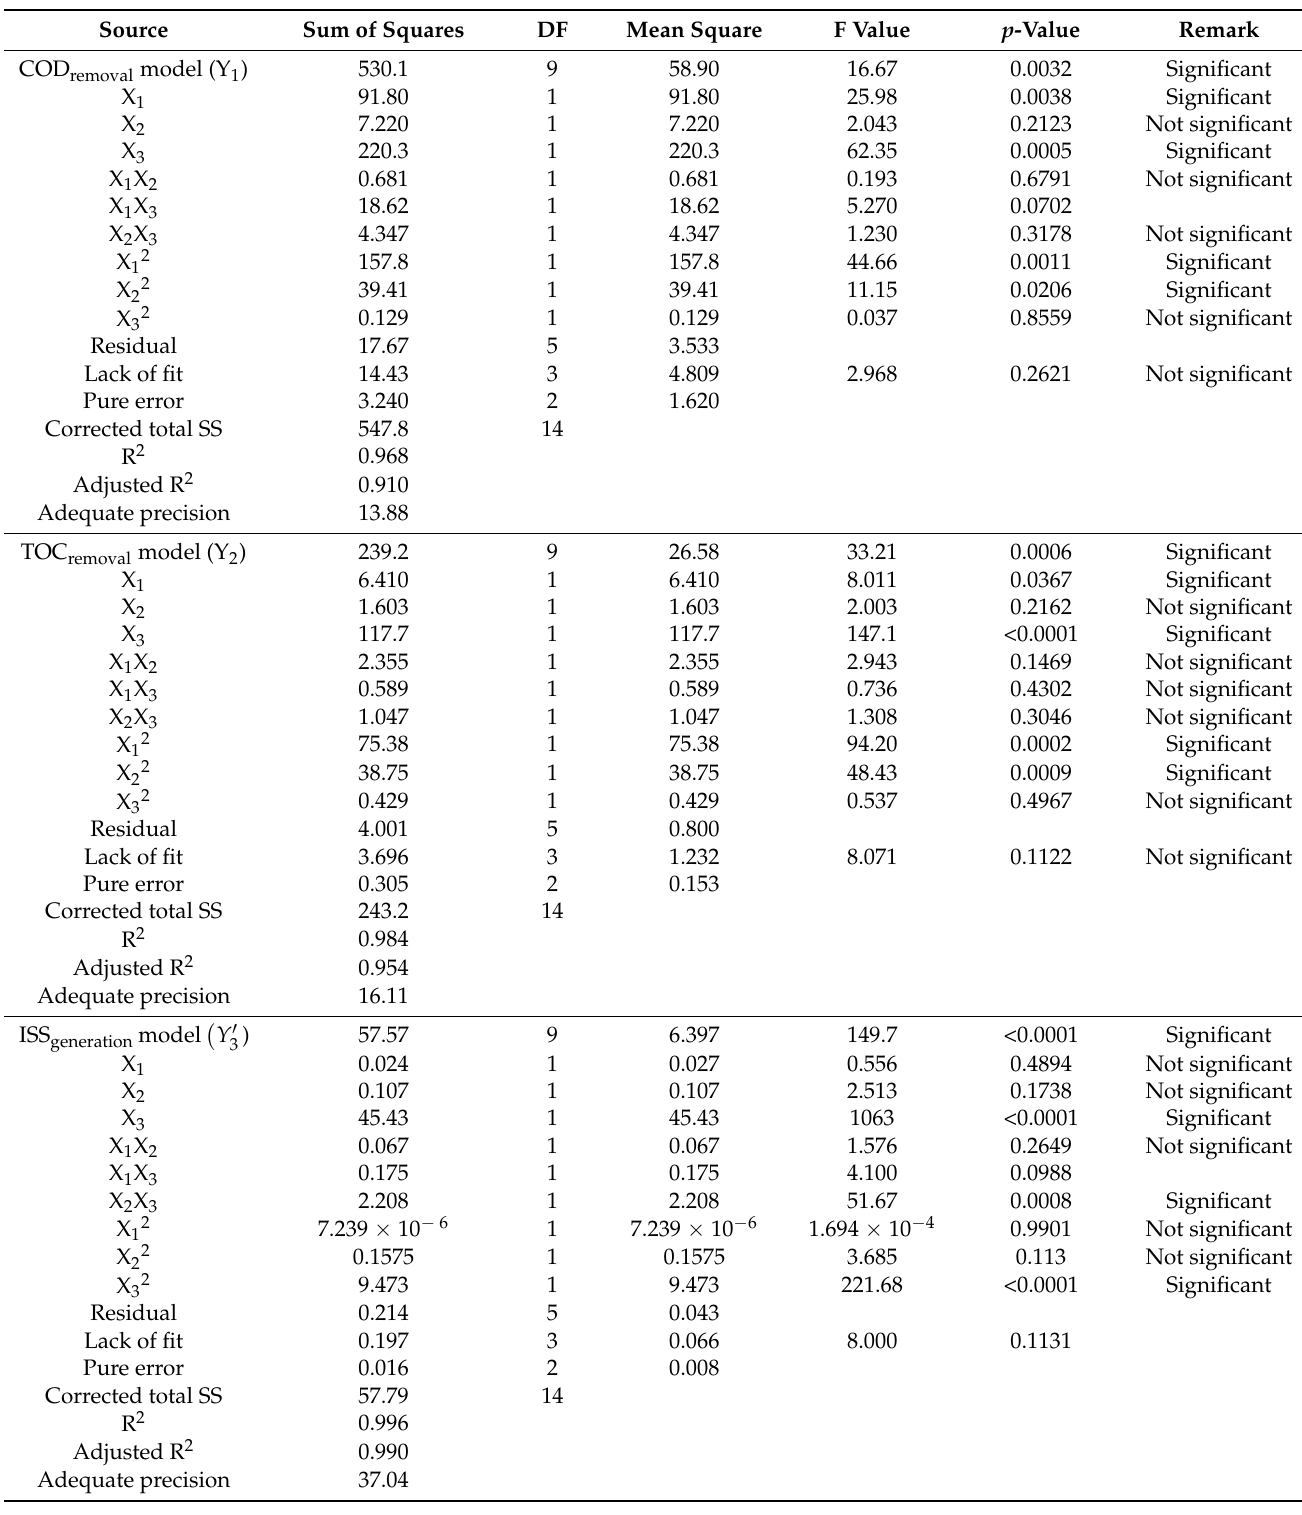
Table 4. ANOVA results for the development of quadratic models to predict COD removal, TOC removal, and ISS